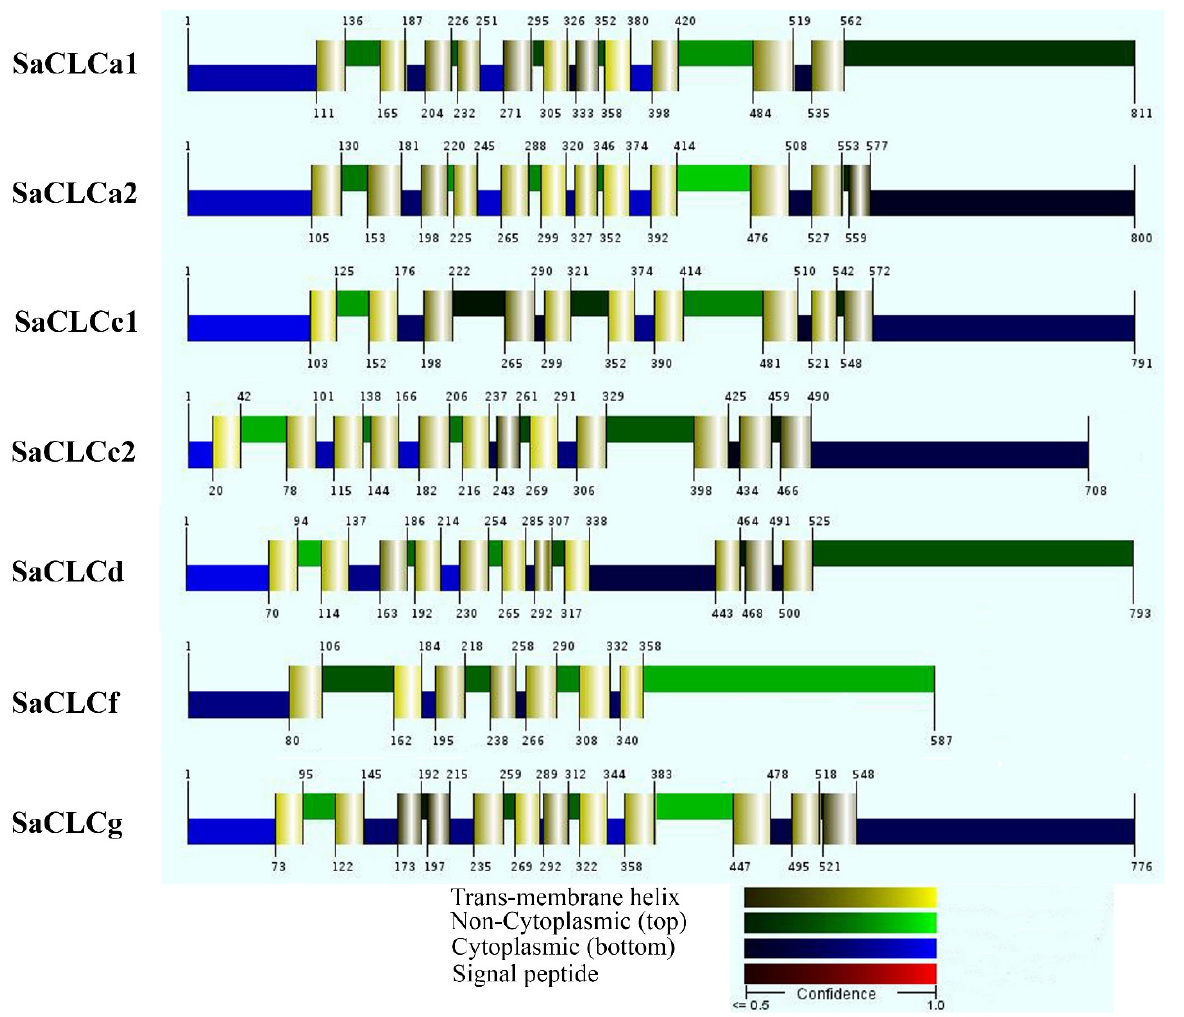
Figure 2. Membrane topology of SaCLC proteins predicted by Philius software (version